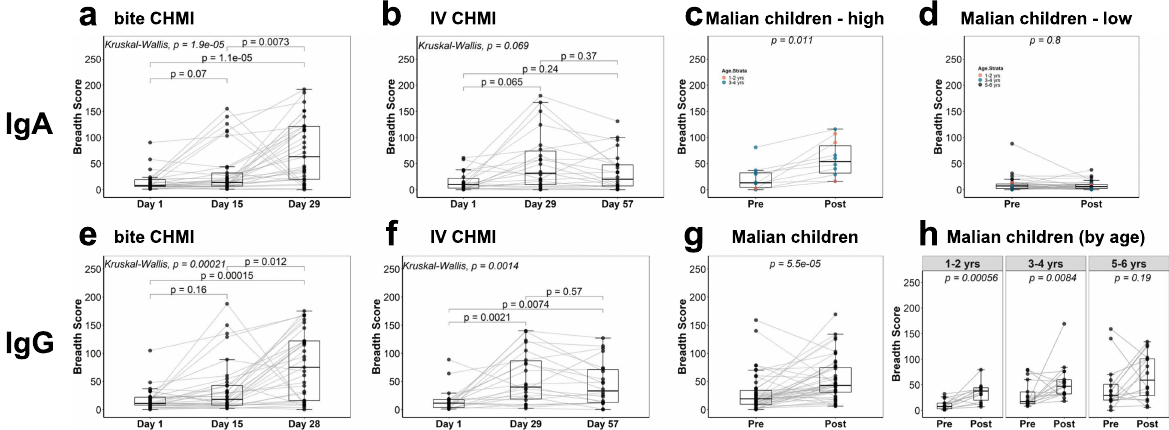
Fig. 5 Change in number of P. falciparum proteins recognized by IgA and IgG for each individual (breadth score) in three clinical studies. Boxplots showing the comparisons of IgA and IgG breadth scores for bite CHMI ( a , e ), IV CHMI ( b , f ) and Malian children ( c , d , g , h ), over time demonstrate that breadth score increases after CHMI for both IgG and IgA. While IgG increases after infection in the Malian children ( g ), IgA increases after infection for the subset of the Malian children whose antibody responses had the highest correlation with CHMI adults ( n = 9, c ) but not for the remaining Malian children whose antibody responses had low correlation with CHMI adults ( n = 38, d ). IgG breadth scores for Malian children strati fi ed by age ( h ) show greatest increase in breadth score for the youngest age stratum. Tests with only two groups used Wilcoxon sign rank test and comparisons of >2 groups used a Kruskal – Wallis test with corrected Dunn ’ s test p